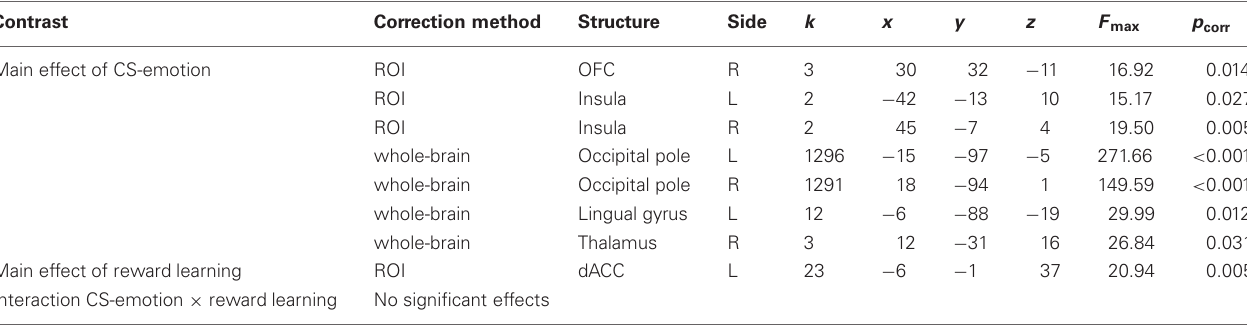
Table 2 | Correction volume, structures, side, cluster sizes ( k ), coordinates of peak voxels, peak F -values, and p corr -values (FWE correction) for the results of the ANOVA of conditioned